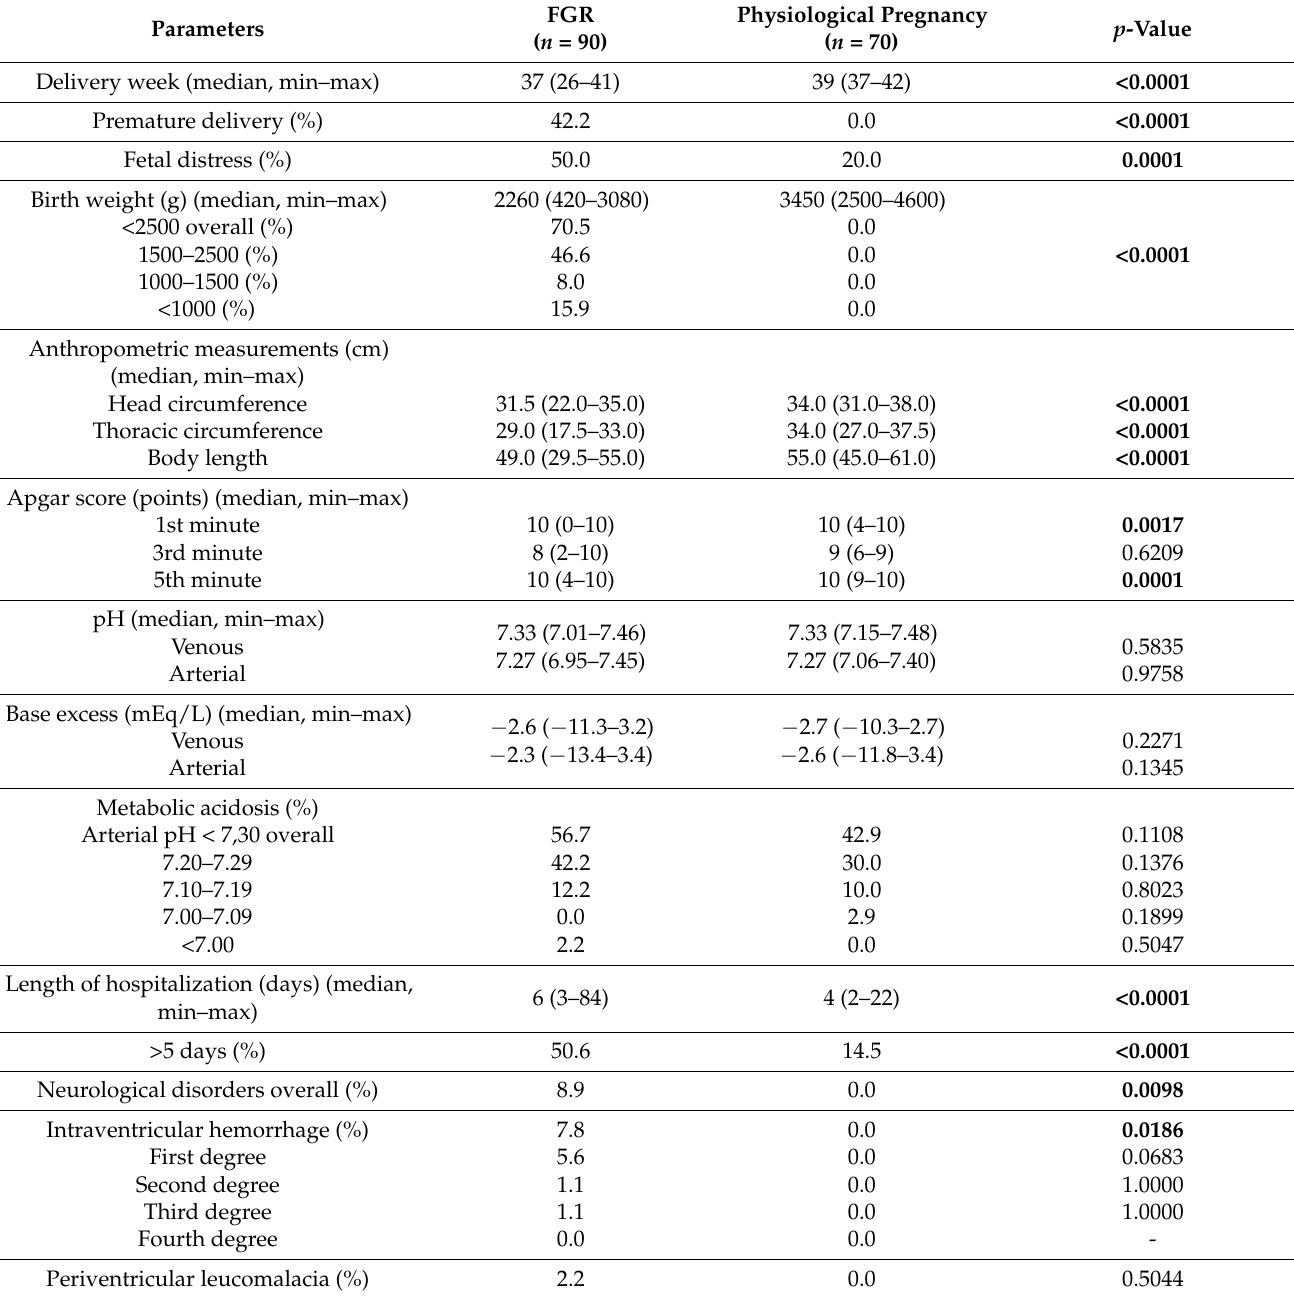
Table 2. The perinatal outcomes of newborns in pregnancies complicated by fetal growth restriction (FGR) and physiological pregnancy. The statistically significant differences between groups are highlighted in